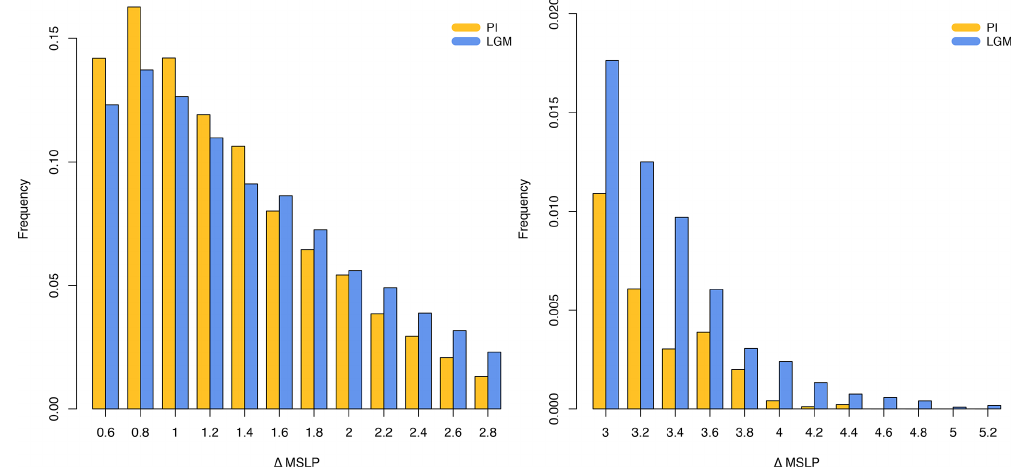
Figure 4. Histogram of cyclone intensity (Laplacian ( (cid:49) ) MSLP) over the North Atlantic (35–70 ◦ N, 70 ◦ W–0). For intense cyclones ( (cid:49)P ≥ 3), the y axis is adjusted (right panel).